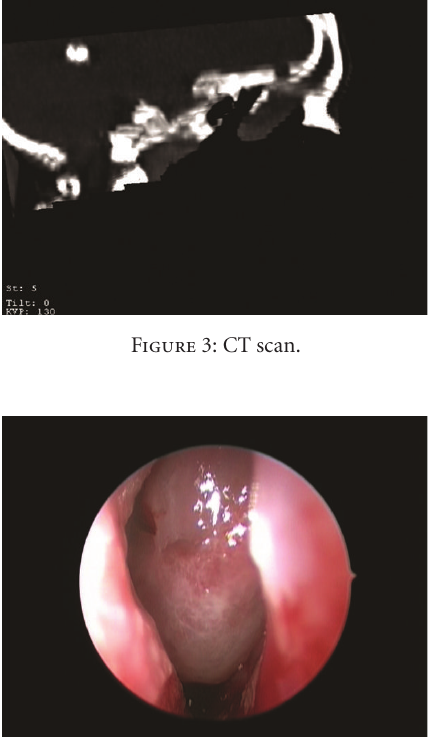
Figure 4: Endoscopic view of big meningoencephalocele within right nasal